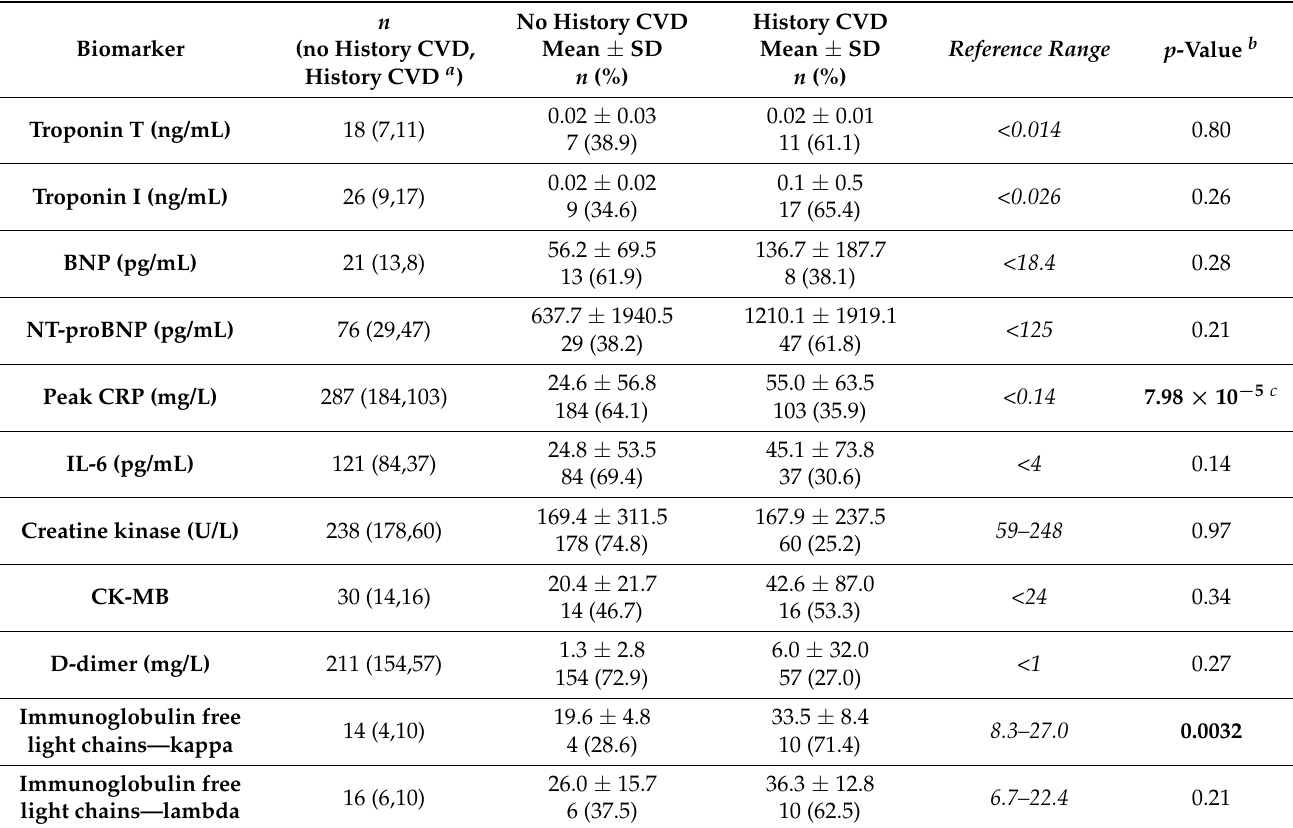
Table 7. Cardiovascular and inflammatory biomarkers found in COVID-19 registry patients with or without a history of